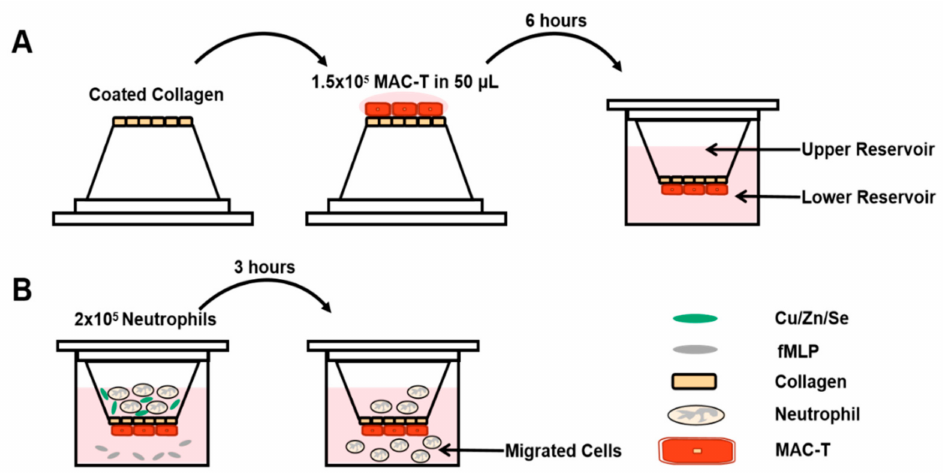
Figure 1. Schematic of experimental design. ( A ) MAC-T were seeded on inverted permeable supports; the supports were placed into a culture dish and incubated at 37 ◦ C to obtain about 90% confluence. ( B ) For selected experiments, neutrophils and additional agents (e.g., Cu) were added to the upper reservoir; fMLP (100 nmol/L) in RPMI 1640 was used as the chemotactic solution in the lower reservoir. Migrated neutrophils were enumerated by the flow